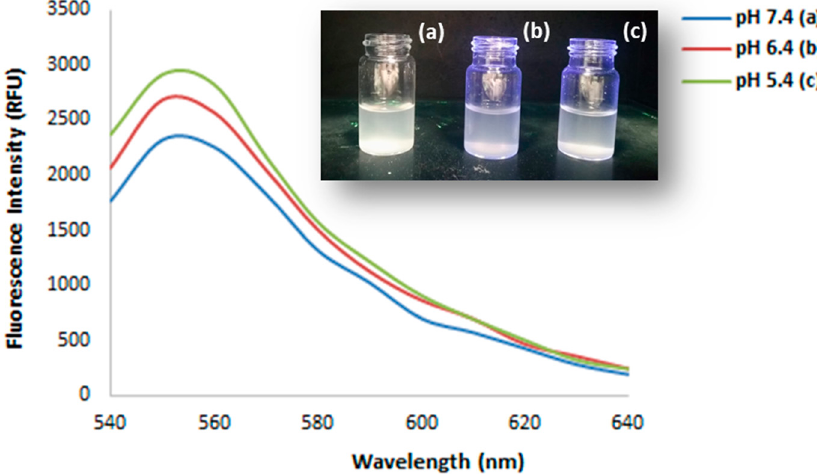
Figure 2. Fluorescence emission spectra of Molecularly Imprinted Polymers (MIP) as a function of the media pH and particles dispersions at pH 7.4 ( a ), 6.4 ( b ), and 5.4 ( c ) under 254 nm UV light.